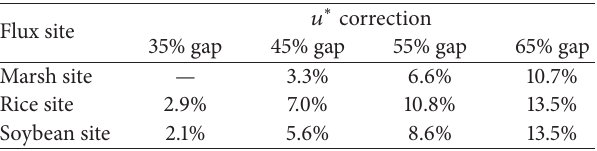
Table2:Thenumberandpercentageoffrictionvelocity( 𝑢 ∗ )filtered data in artificial